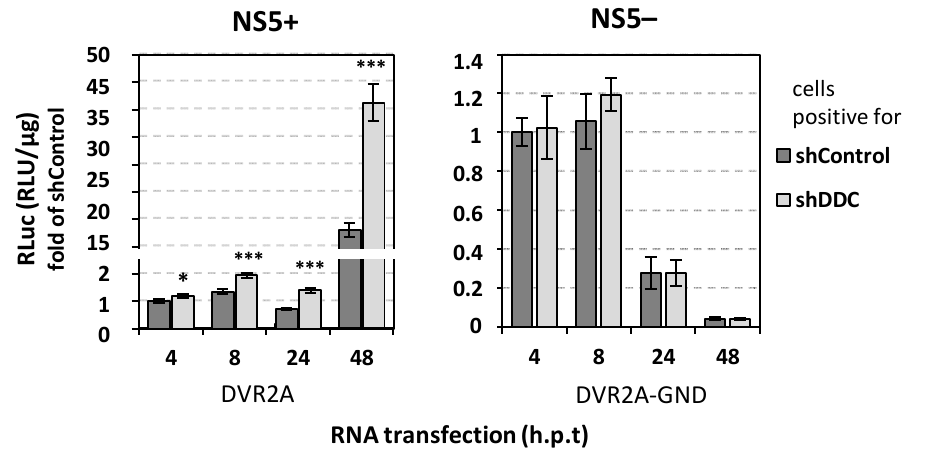
Figure 2. DDC silencing affects DV genome replication but not translation. Huh7.5 cells stably expressing shDDC or shControl were transfected with the in vitro transcribed RNA derived from the subgenomic reporter pFK-sgDVR2A (NS5+) (left panel), or its replication deficient mutant pFK-sgDVR2A-GND (NS5 − ) (right panel) and then cultured for the indicated time points. Then, the cells were lysed and Renilla luciferase enzymatic activity was quantified. Values were normalized to the ones obtained at 4 h and expressed as fold of the ones obtained in shControl-expressing cells. Data shown are means ± standard deviations of values from three biologically independent transfection experiments in three technical replicates. Values derived from shControl-expressing cells were set as one. * p < 0.05, *** p < 0.001 vs. shControl.